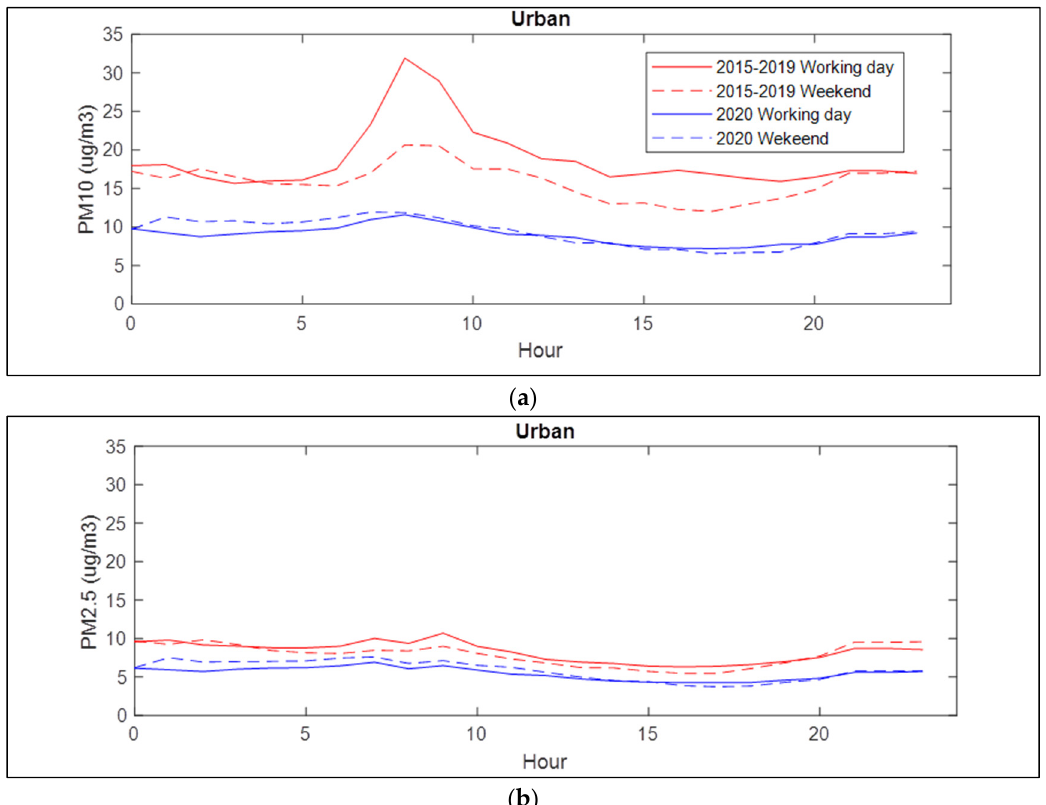
Figure 6. Hourly PM 10 ( a ) and PM 2.5 ( b ) concentration profile of working days and weekends for the reference and lockdown periods.